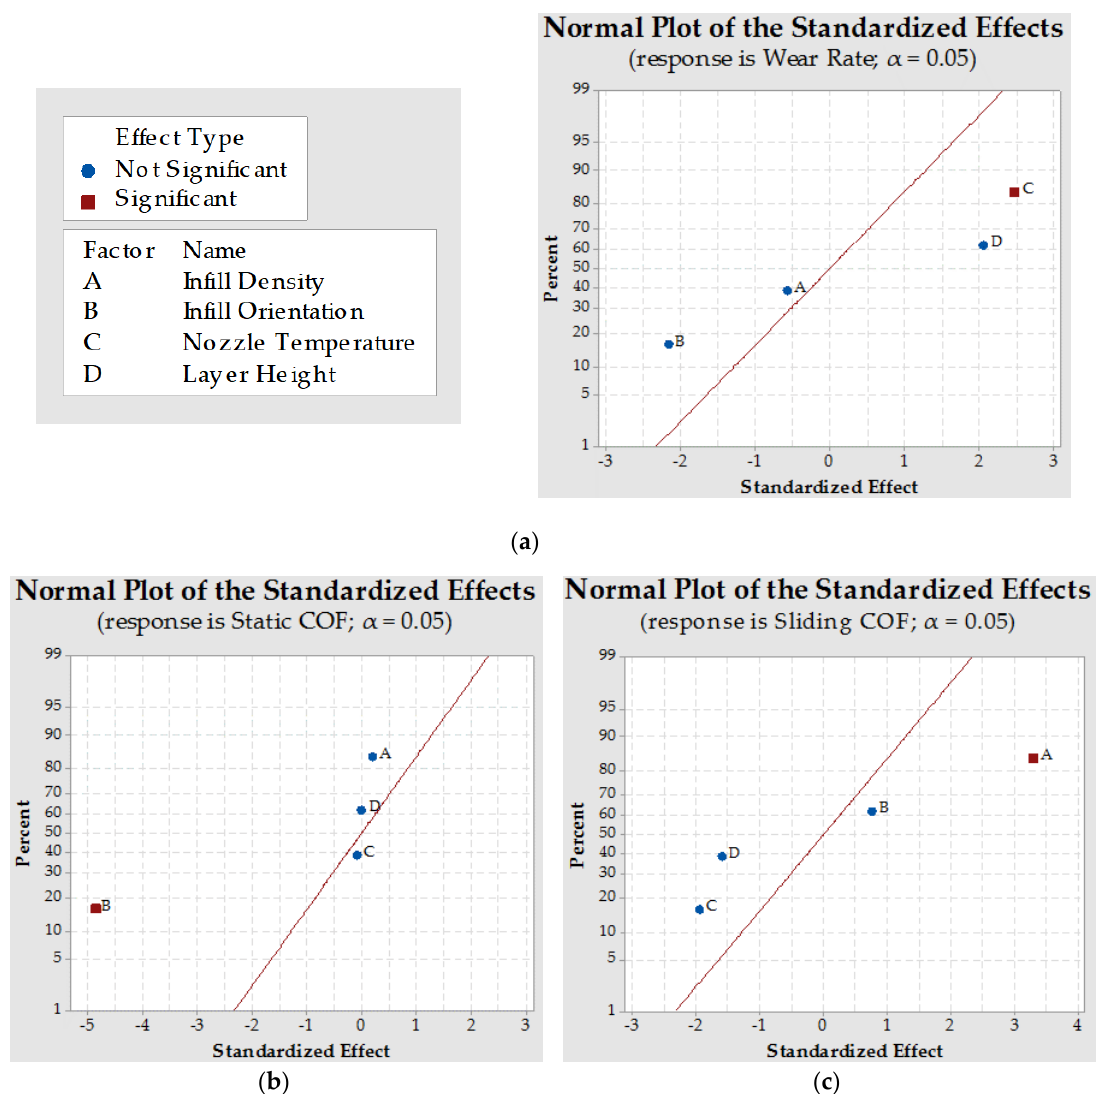
Figure 9. Normal probability plots of the effects for interpreting the significance on a level of 0.05 of the four factors infill density, infill orientation, nozzle temperature, and layer height on the three responses wear rate ( a ) and the coefficients of static ( b ) and sliding ( c ) friction.